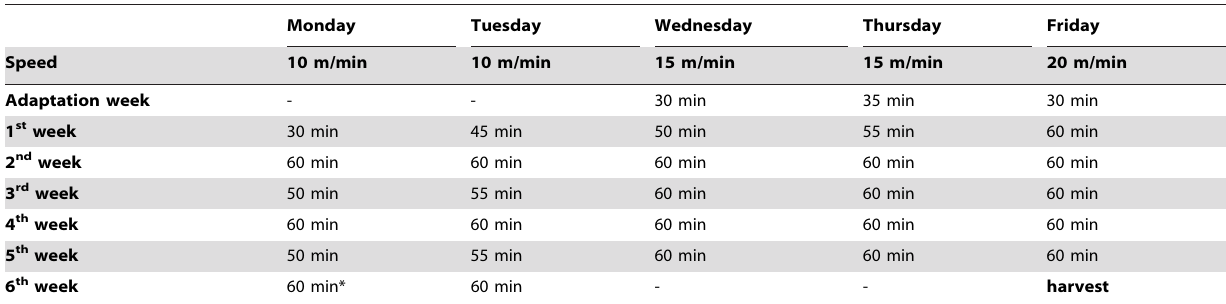
Table 1. Chronic